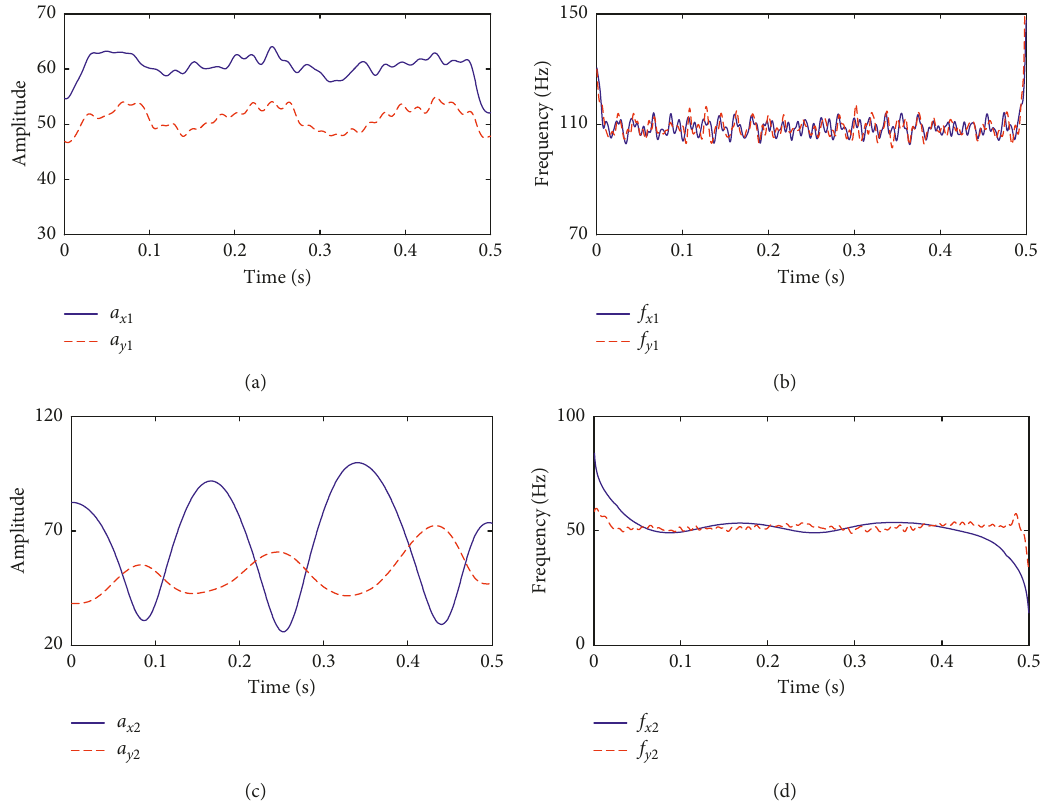
Figure 14: (a) The instantaneous amplitude of the real part and imaginary part of cpf imaginary part of cpf 1 ; (c) the instantaneous amplitude of the real part and imaginary part of cpf 2 ; (d) the instantaneous frequency of the real part and imaginary part of cpf 2